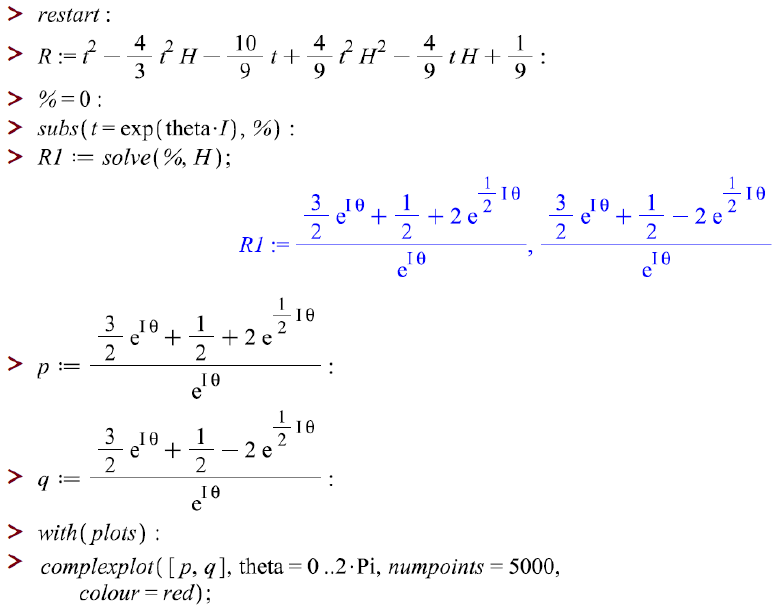
Figure 2. MAPLE codes to construct stability graph of 2-point SDIBBDF